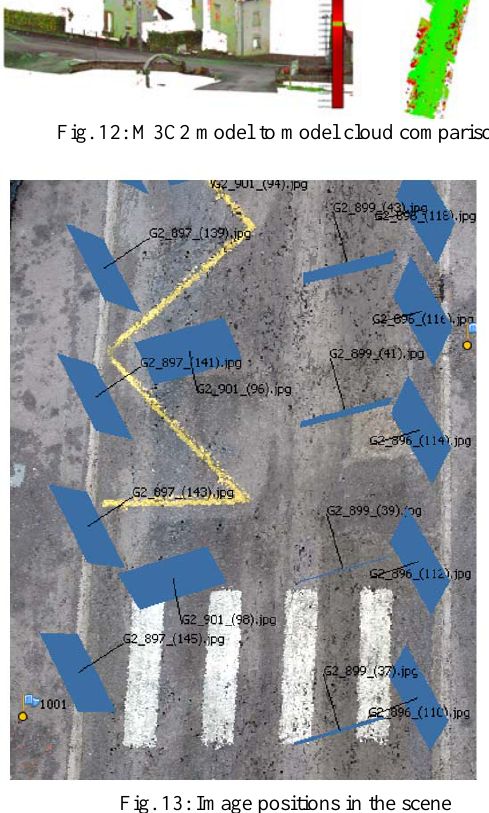
Fig. 14: Dense point cloud